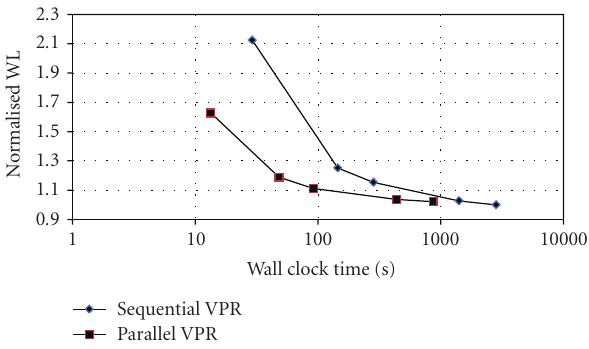
Figure 8: Placement quality-runtime envelope curves for the old sequential and new parallel VPR placement tools. Every data point is the average over all test